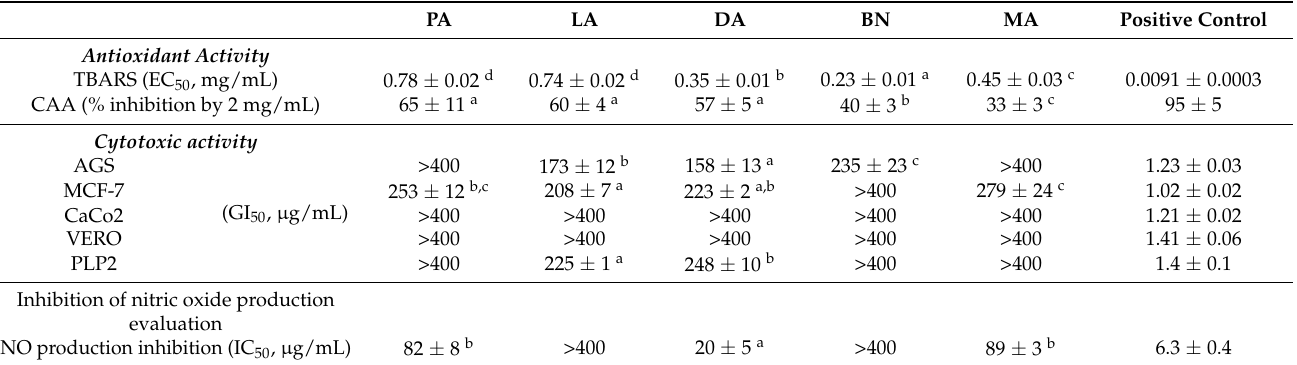
Table 7. Antioxidant, cytotoxic activity, and inhibition of nitric oxide production evaluation of the extracts obtained from fig